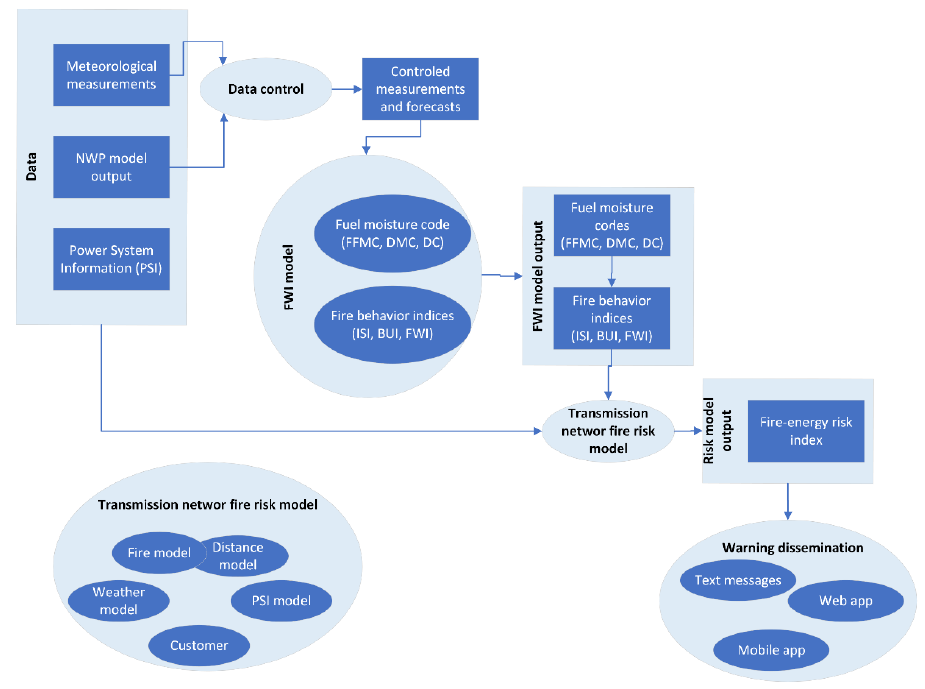
Figure 5. Weather hazard detection process, an example for a fire event.